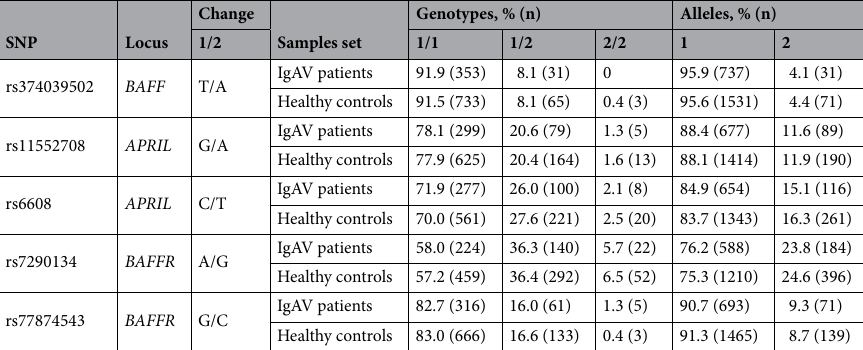
Table 2. Genotype and allele frequencies of BAFF, APRIL and BAFFR in patients with IgAV and healthy controls. IgAV: IgA vasculitis; SNP: single nucleotide polymorphism. No statistically significant differences in BAFF, APRIL and BAFFR genotype and allele frequencies were disclosed when patients with IgAV were compared to healthy controls (p ≥ 0.05 in all the